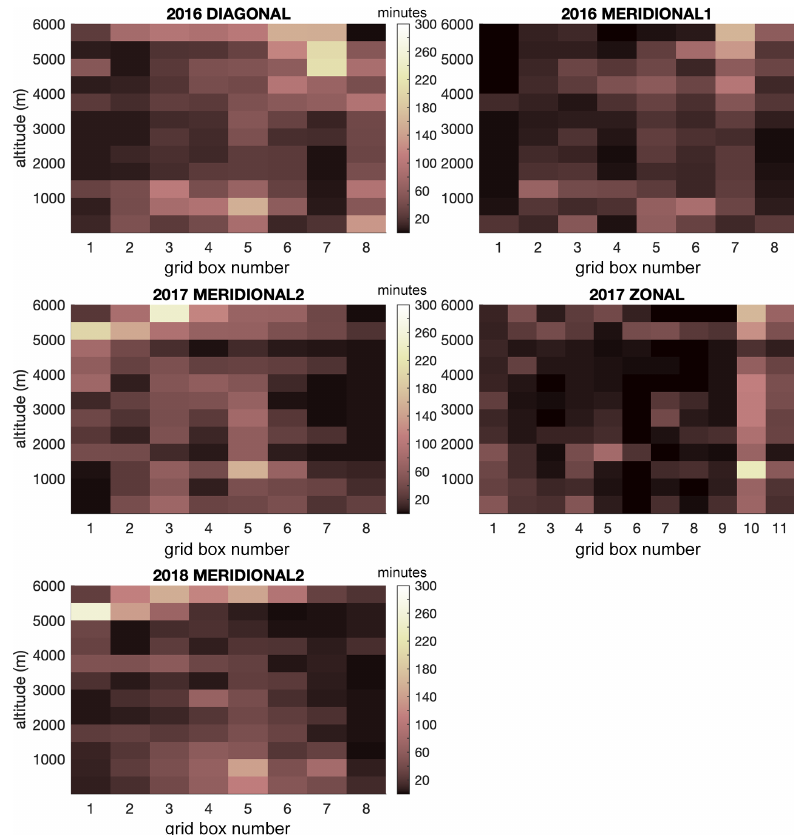
Figure 2. The number of minutes the P-3 aircraft spent in each grid box and 500m altitude bin for the comparison transects shown in Fig. 1. The 2016 diagonal and 2017 and 2018 meridional 2 transects cover the routine flight tracks, which targeted semi-random sampling. Not all in situ measurements have data available for all times, so the number of minutes of available data may be less than the number of minutes the P-3 was present in a given grid box and altitude